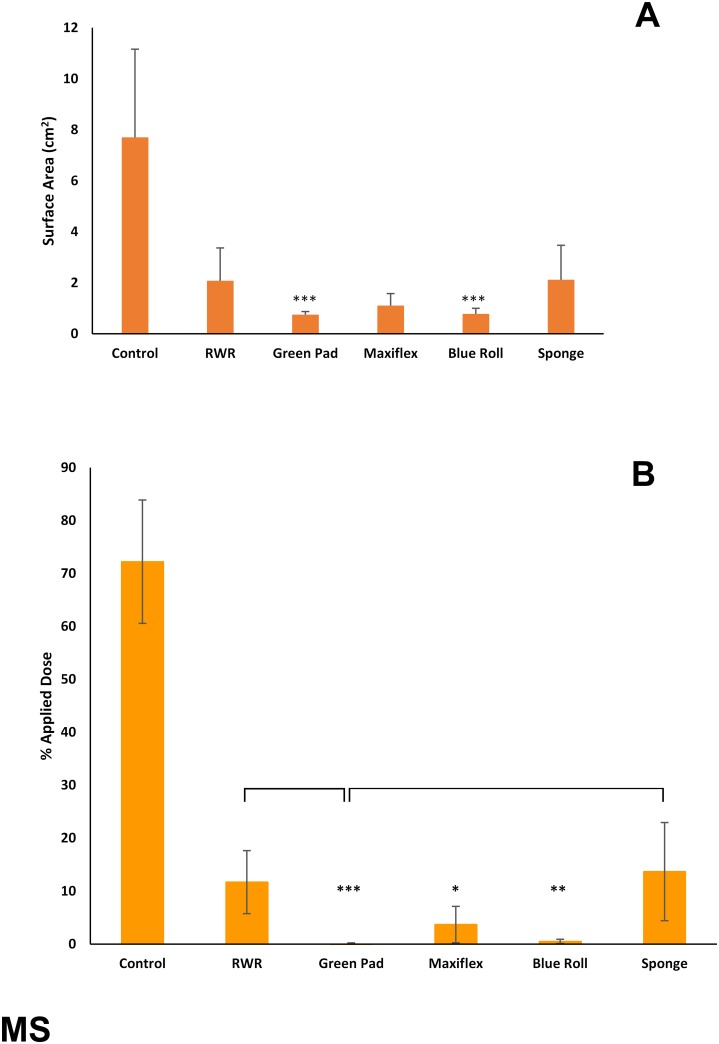
(A) Skin surface spreading and (B) recovery of 14C-methyl salicylate (expressed as percentage of applied dose) remaining on, within or penetrated through dermatomed pig skin following decontamination (after 15 minutes) with test products (green incontinence pads, Maxiflex wound dressing, absorbent tissue paper (blue roll) or polyurethane sponge) or the rinse-wipe-rinse method (RWR).All values are mean ± standard deviation of n = 6 replicates. Asterisks indicate significant differences between treated and untreated (control) skin: *p<0.05; **p<0.01; ***p<0.001. Horizontal brackets indicate significant differences (p<0.05) between treatment groups.